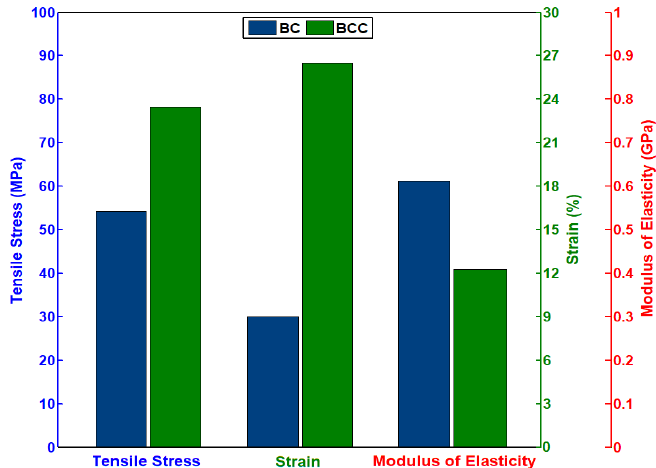
Figure 5. Tensile strength, strain (%), and modulus of elasticity of BC and BCC composite.